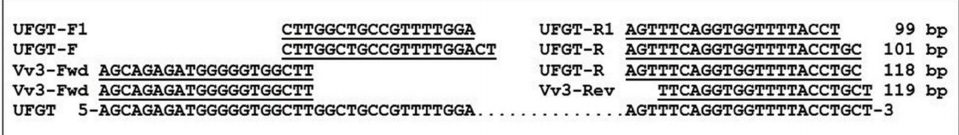
Figure 2. Partial nucleotide sequences of the UFGT gene flanked by different sets of